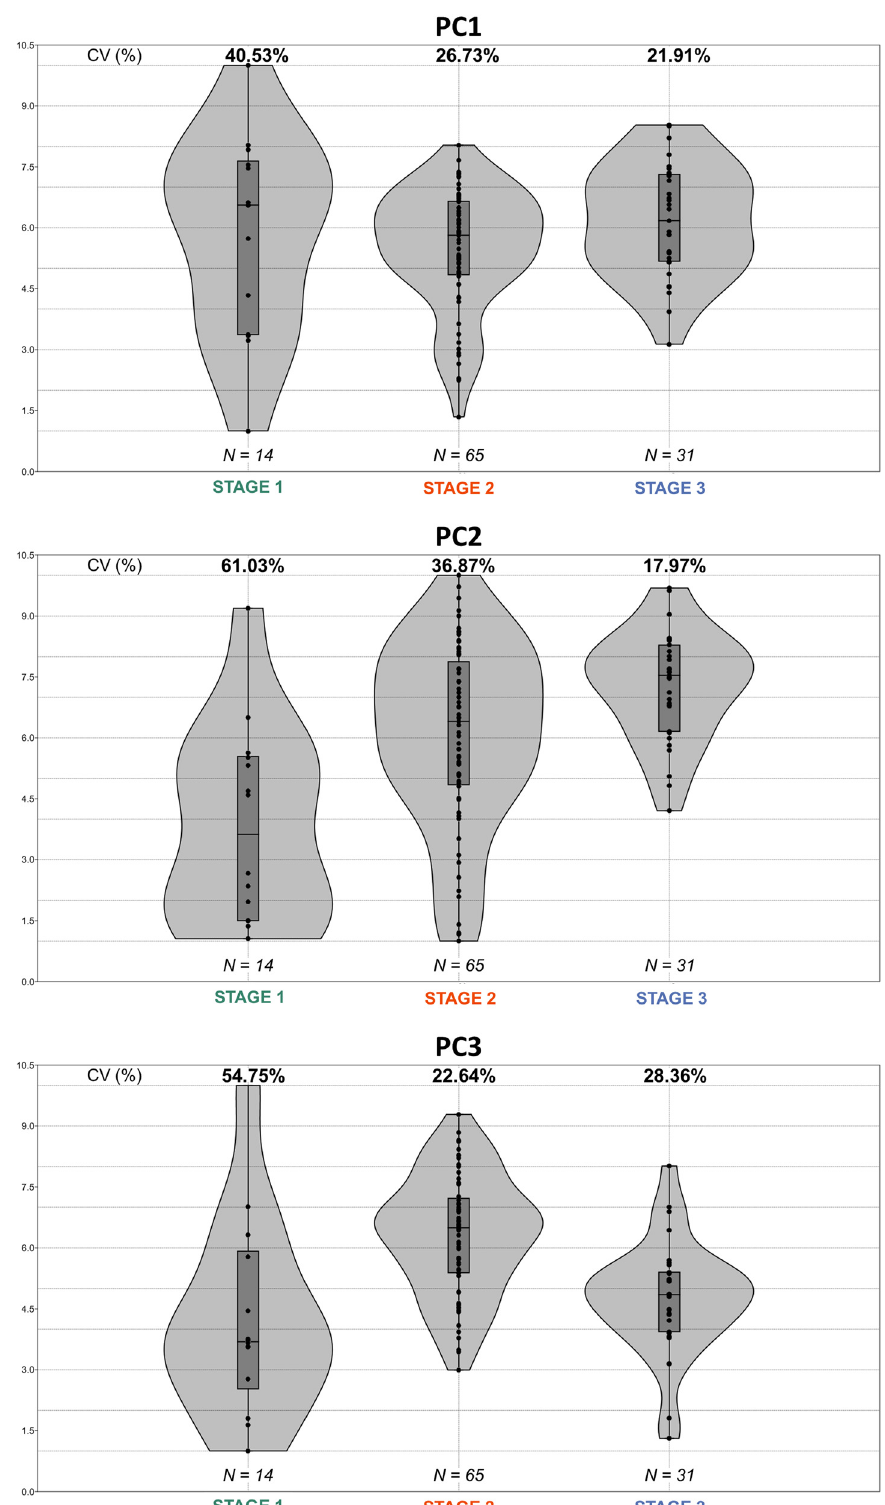
Figure 12: Normalized PC1 – 3 score distribution and overlaid CV scores across three